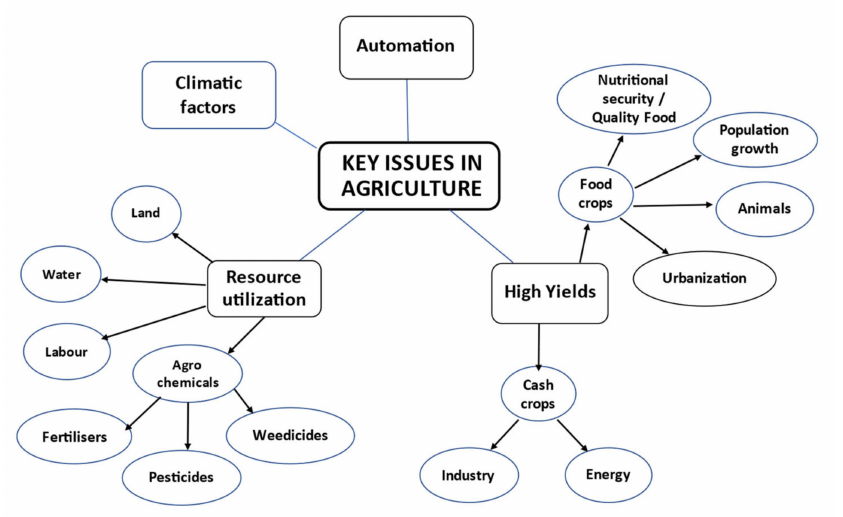
Figure 2. Key issues of technology in the agriculture